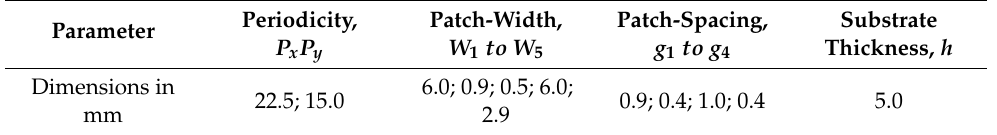
Table 1. Design dimensions for multi-bit unit